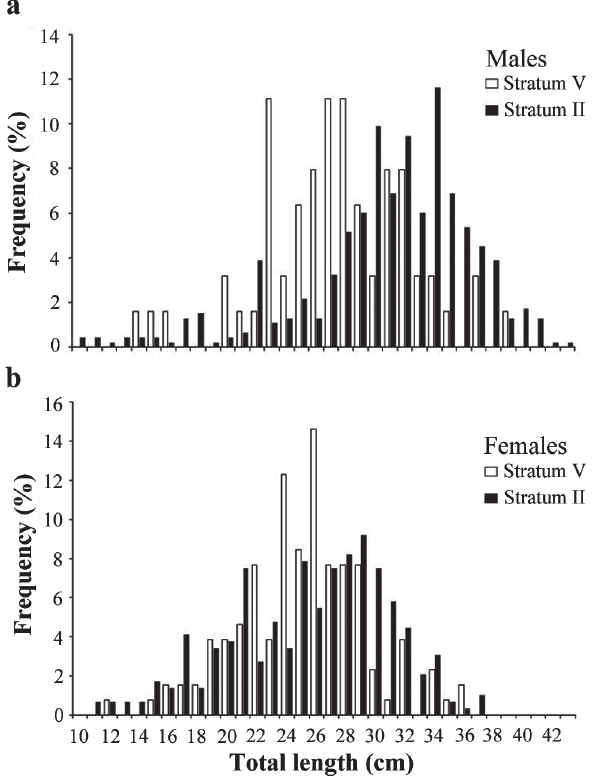
Fig. 3. Comparison of the length frequency distributions of the individuals collected during the bottom trawl surveys REDEs 2004- 2007. a) Males; b) Females.